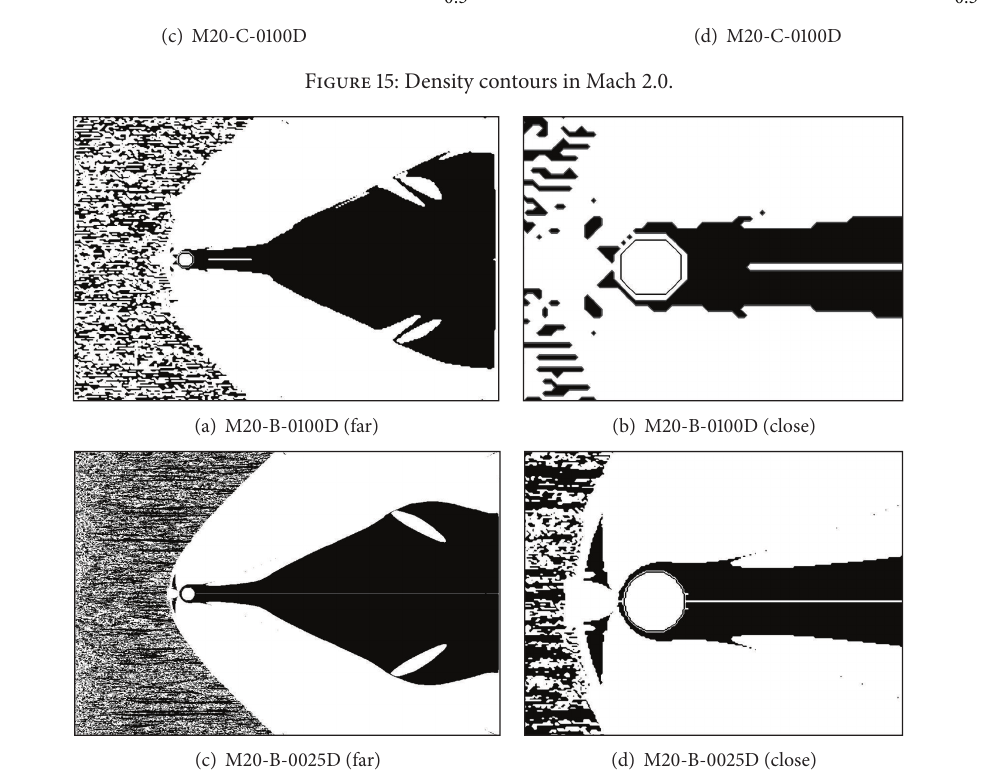
Figure 16: Visualization of switching parameter 𝛽 (white: 𝛽 = 1, black: 𝛽 =